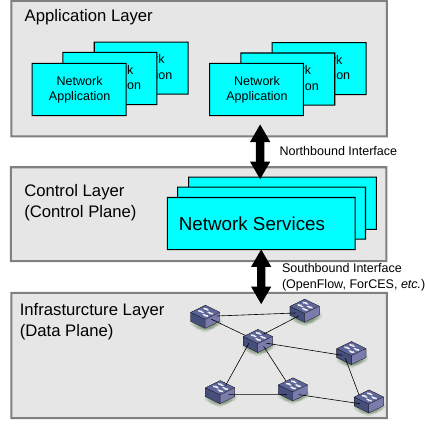
Figure 1. A three-layer software-defined networking (SDN) architecture.